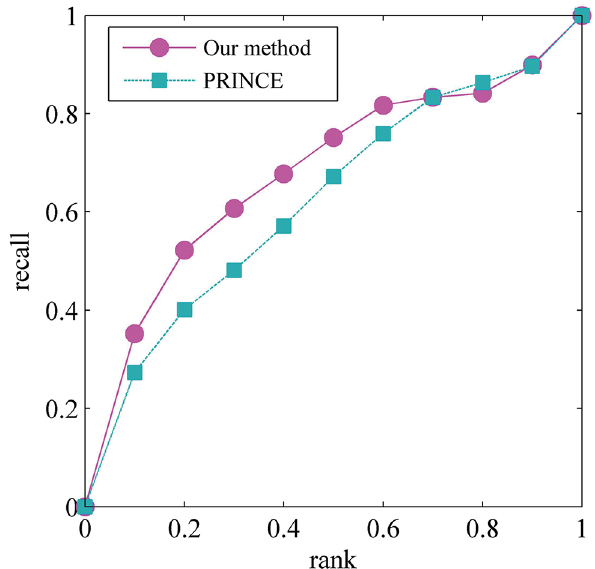
Fig 3. Comparison in performance between our method and PRINCE. A plot of recall versus rank threshold, rank threshold k % means that the gene was ranked within top k %.